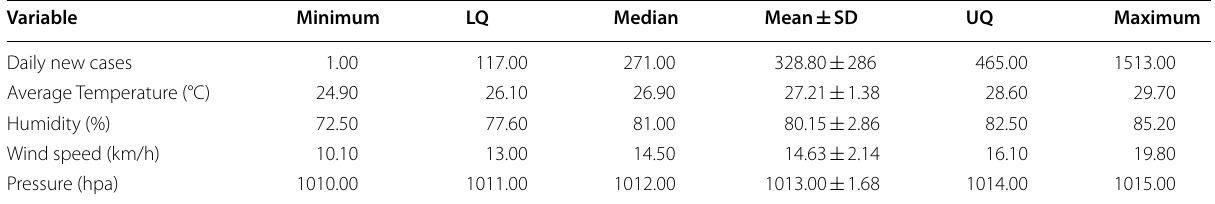
SD represents standard deviation; LQ and UQ represent the lower and upper quartile respectively